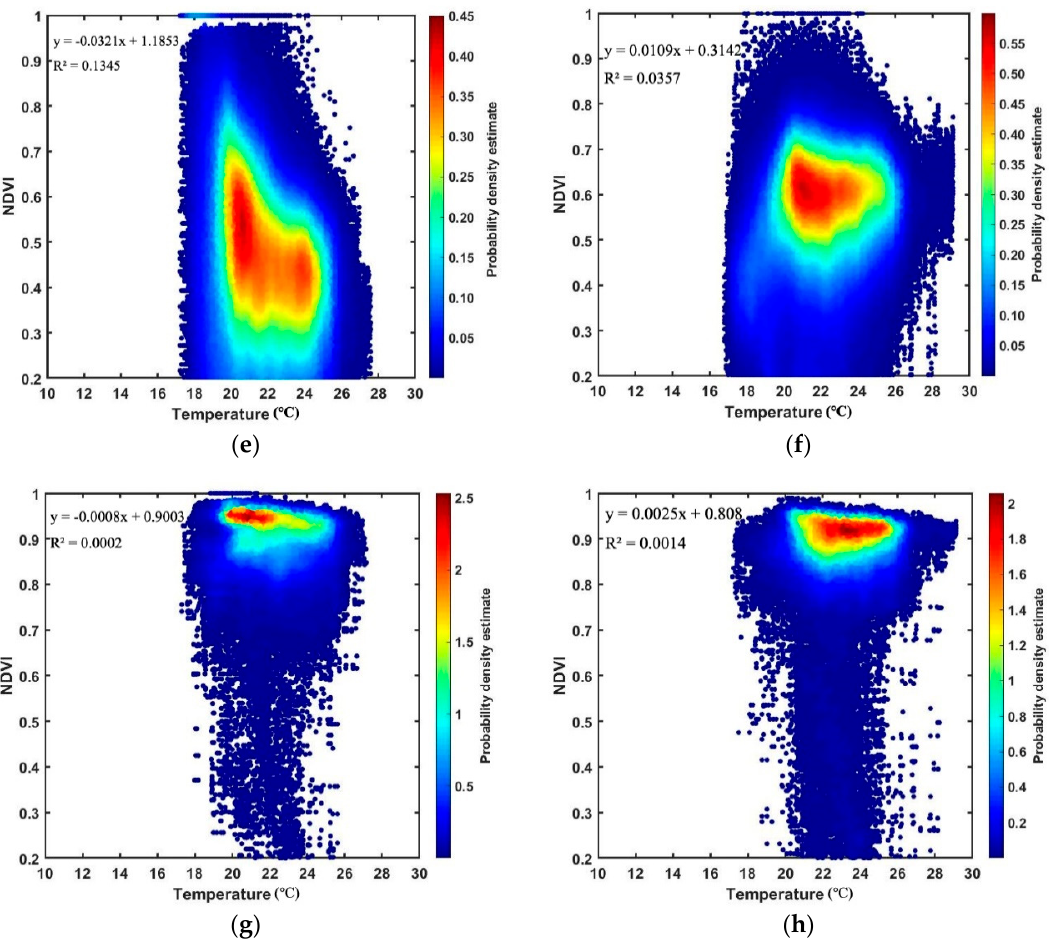
Figure 4. Ts-NDVI spaces of each site. ( a ) Site A1; ( b ) Site A2; ( c ) Site B1; ( d ) Site B2; ( e ) Site C1; ( f ) Site C2; ( g ) Site C1HSI; ( h ) Site C2HSI. The scatter points are marked in gradually-changed colors